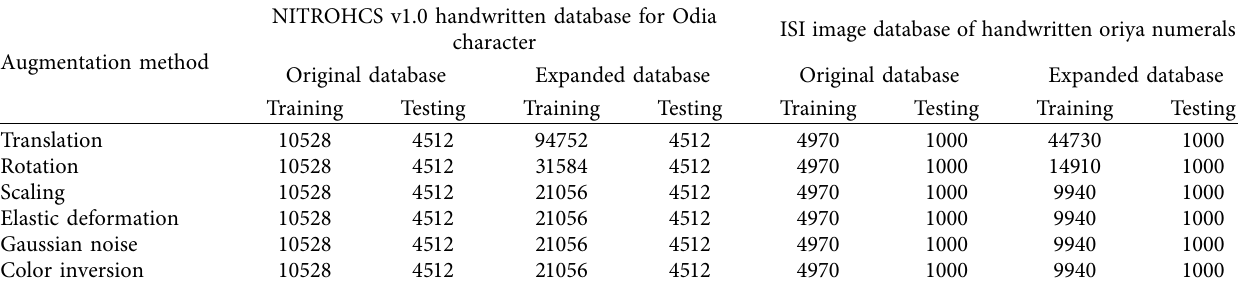
Figure 2: Sample numerals of ISI image database. Table 2: Database size after augmentation and splitting